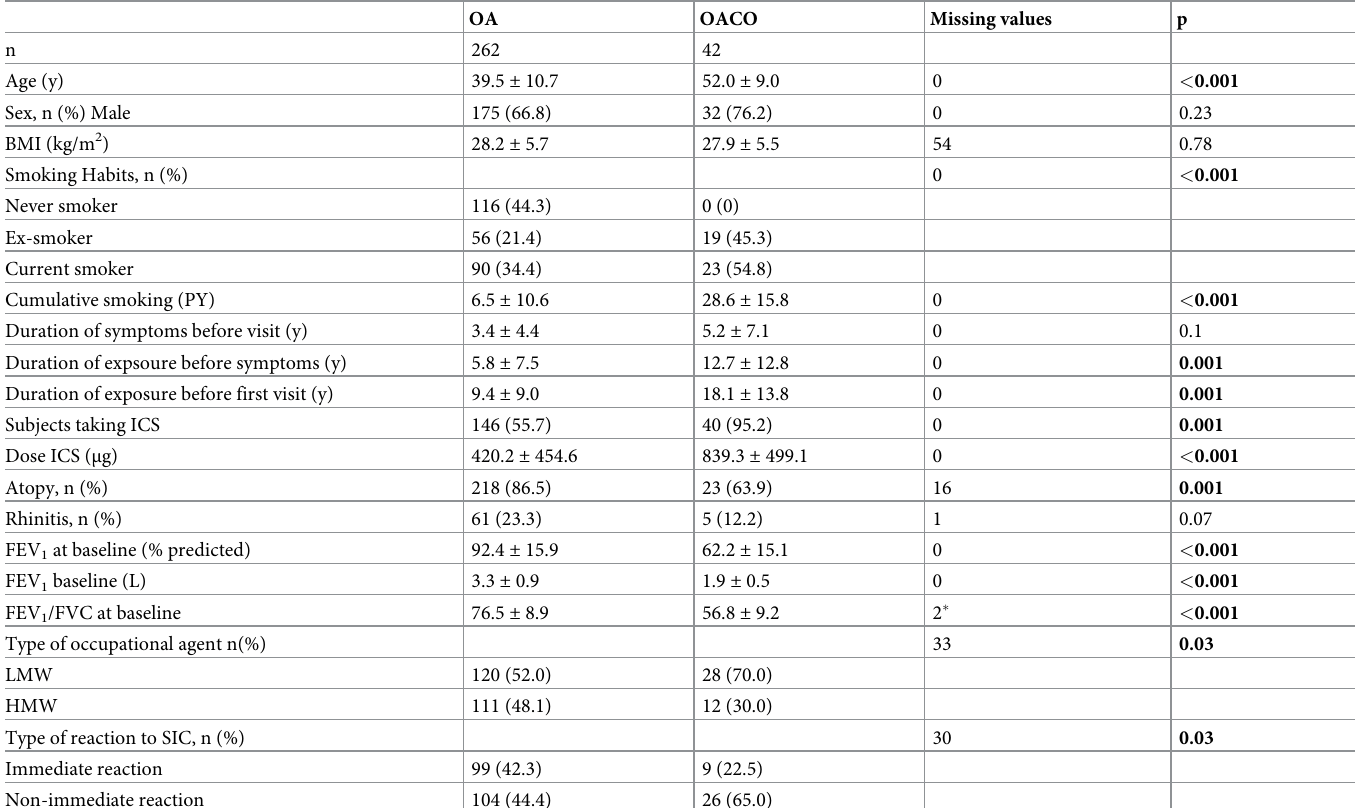
Table 1. Clinical characteristics of the study